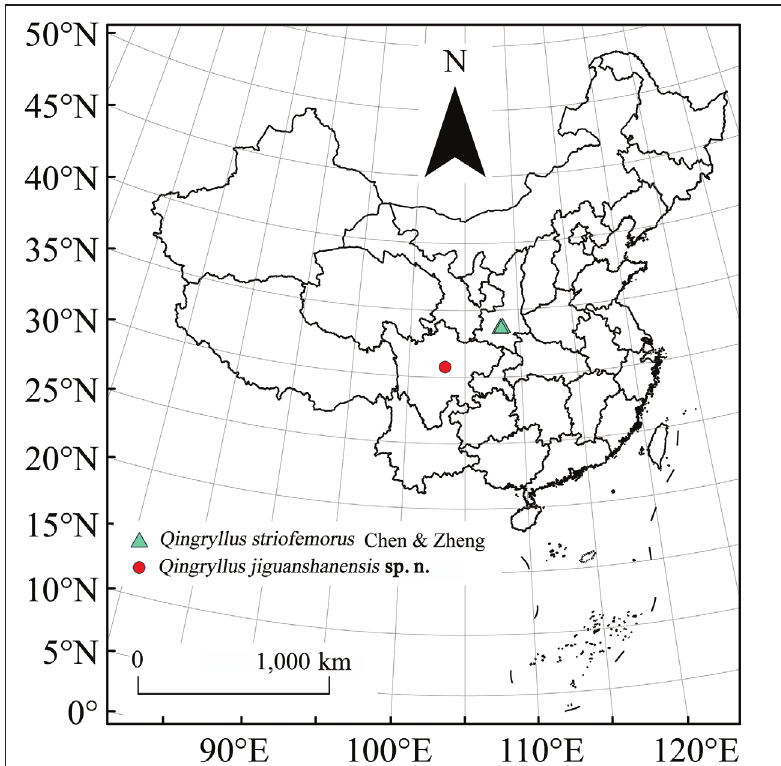
Figure 1. Distribution map of the genus Qingryllus Chen &